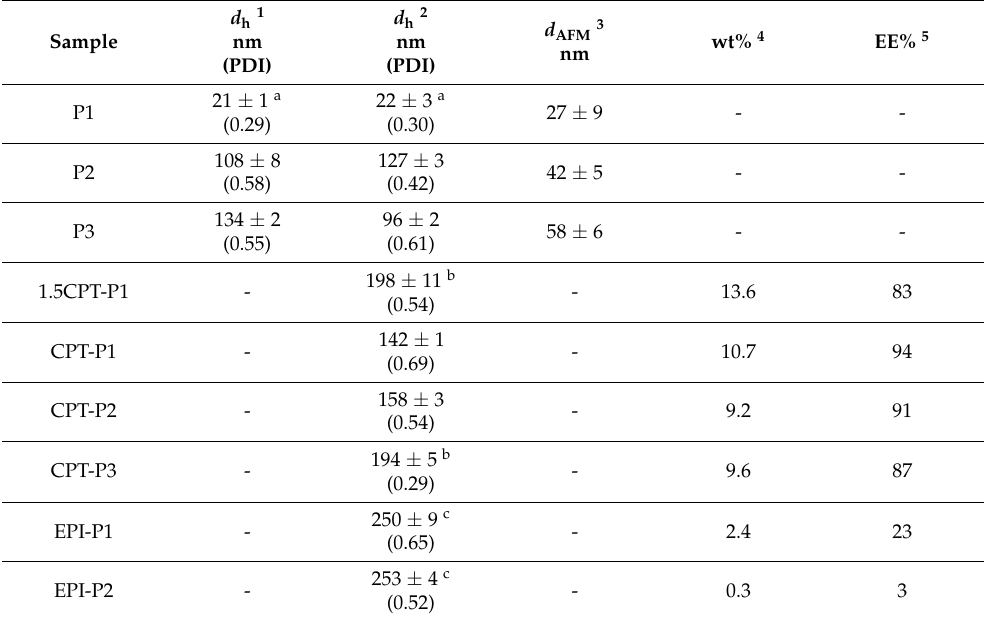
Table 2. Hydrodynamic sizes, average diameters by AFM of dried nanoaggregates P1–P3, anticancer drug weight contents (wt%) and encapsulation efficiency (EE%) of the anticancer